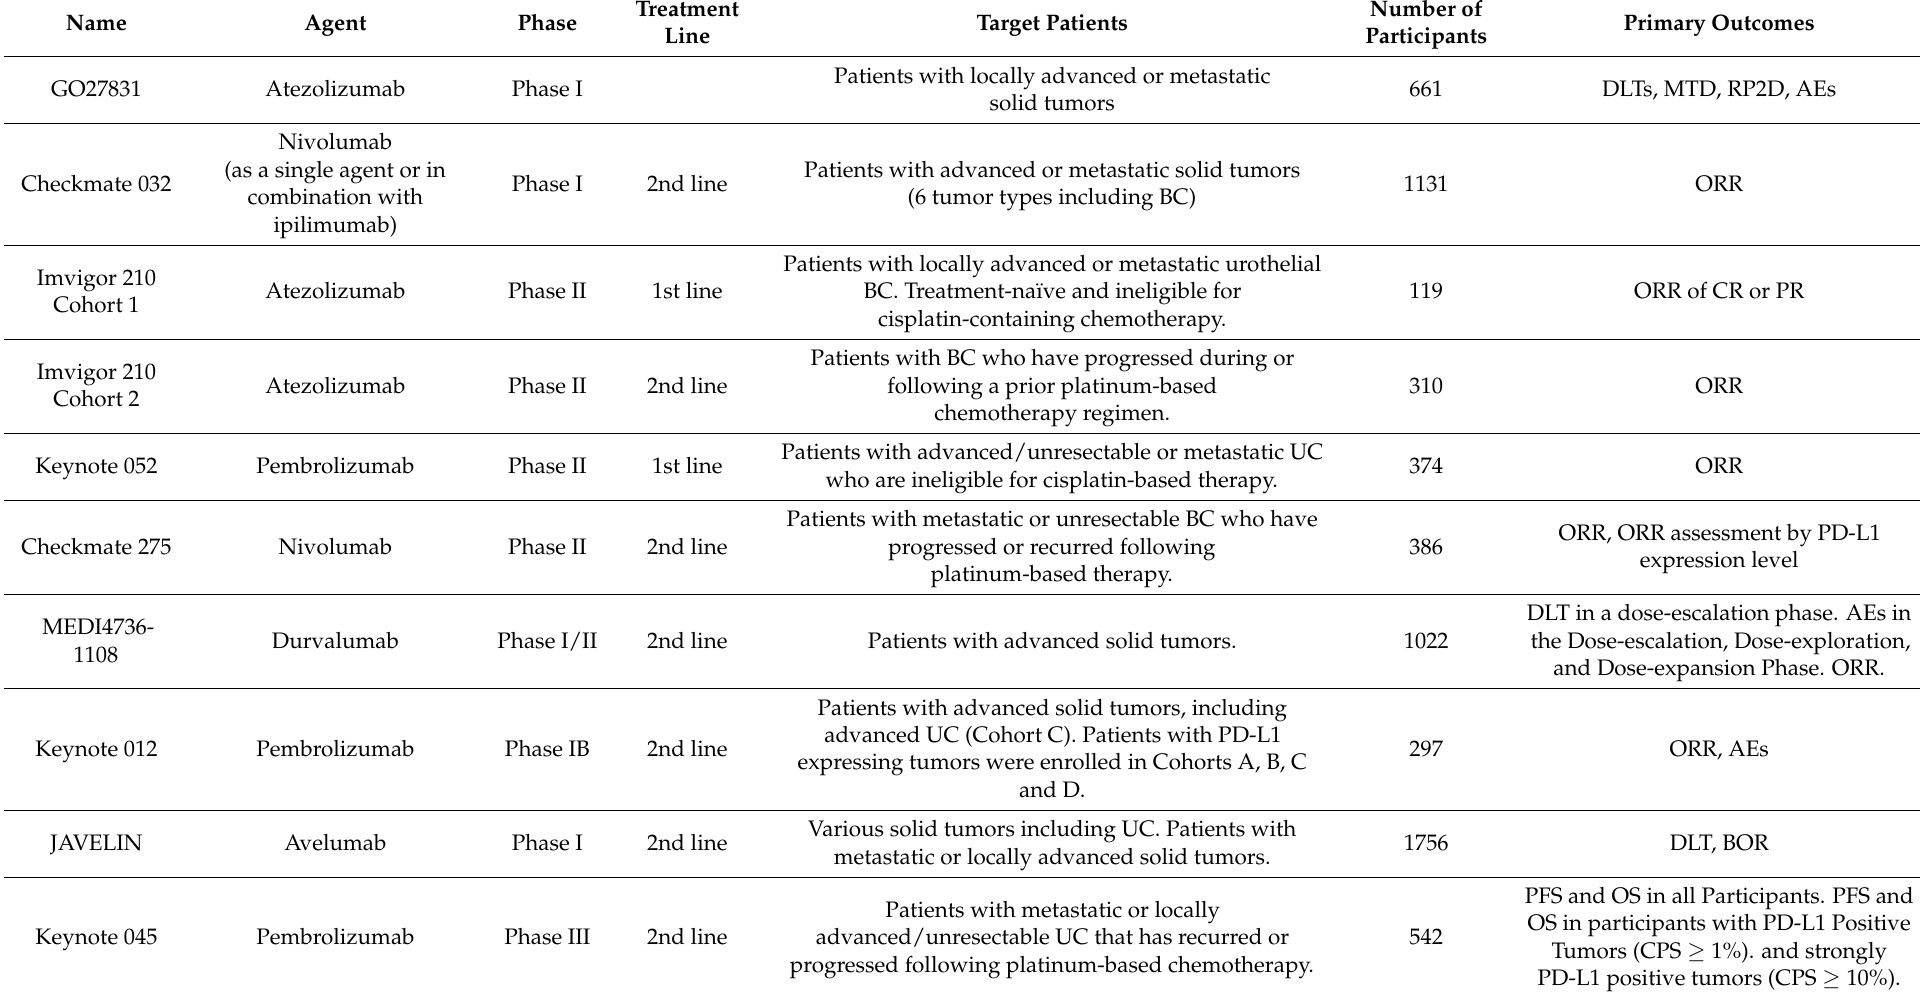
Table 2. Key trials with ICIs, targeted therapies, and antibody-drug